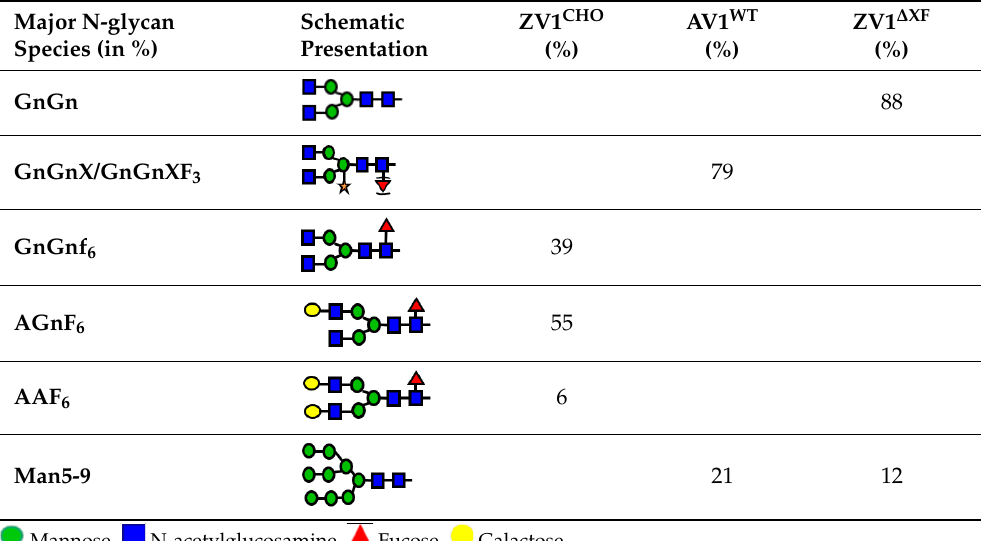
Figure 1. Temporal expression of ZV1 in N. benthamiana leaves. Leaves of WT ( A ) and Δ XFT ( B ) N.